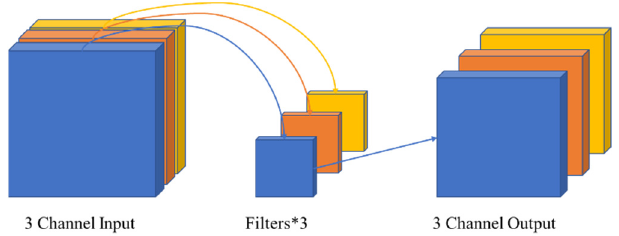
Figure 2. Depthwise convolution operation.